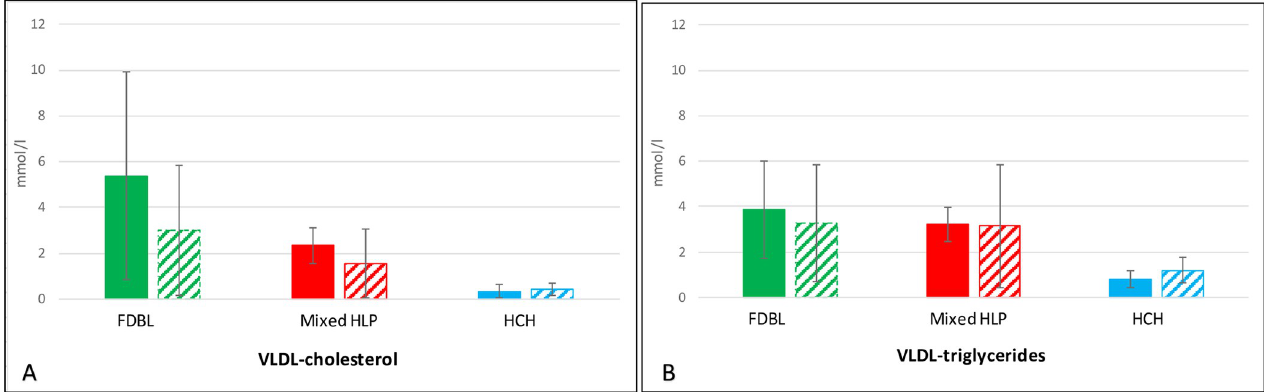
Fig 1. VLDL-cholesterol (panel A) and VLDL-triglycerides (panel B) before (baseline, filled columns) and after 12 weeks (striped columns) of PCSK9 inhibition. Different colors indicate different patient groups. Shown are means ± SD; green: FDBL, familial dysbetalipoproteinemia; red: mixed HLP, mixed hyperlipidemia; blue: HCH,